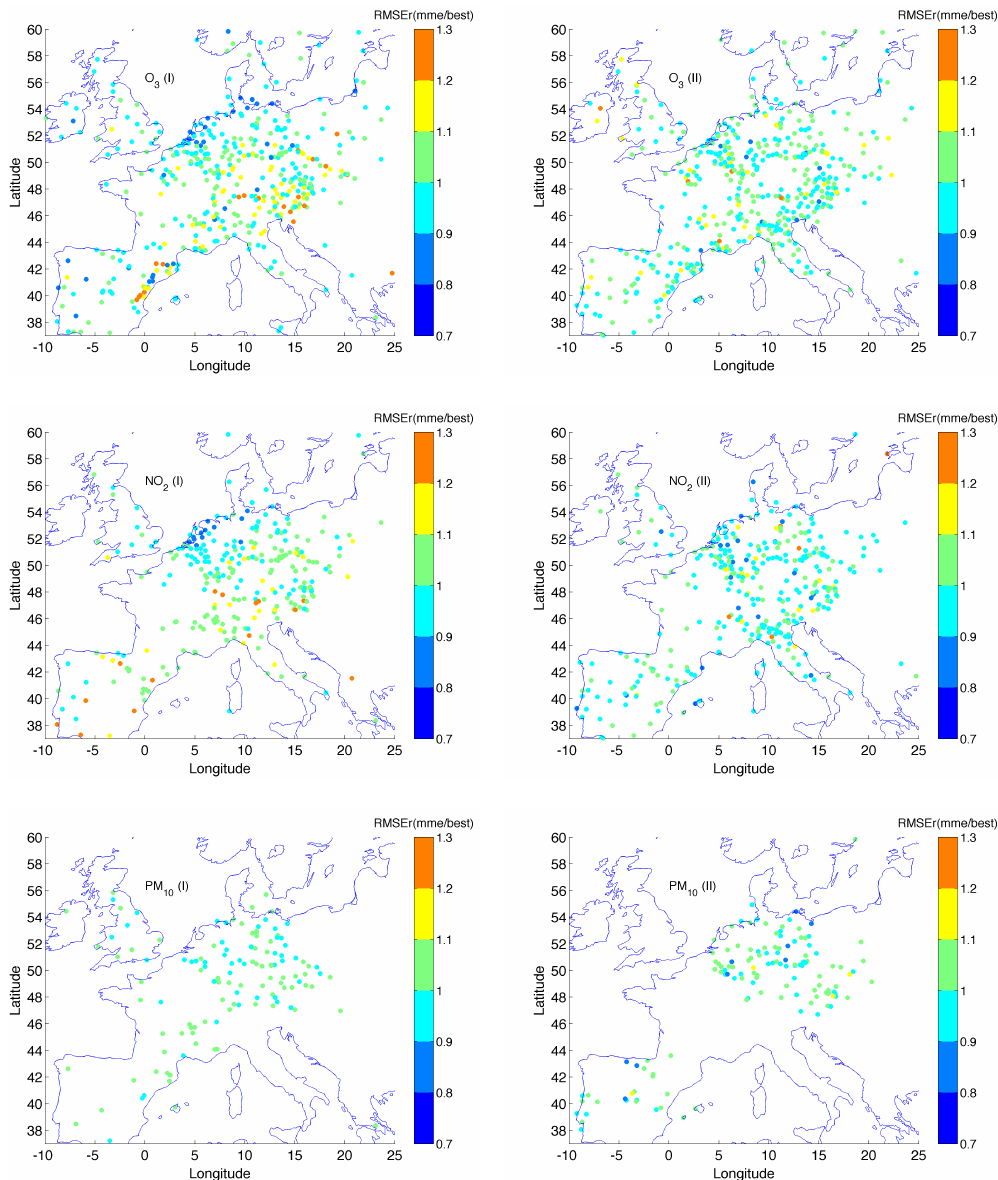
Figure 3. Comparison of the mme skill against the best local deterministic model by means of the indicator RMSE MME /RMSE BEST